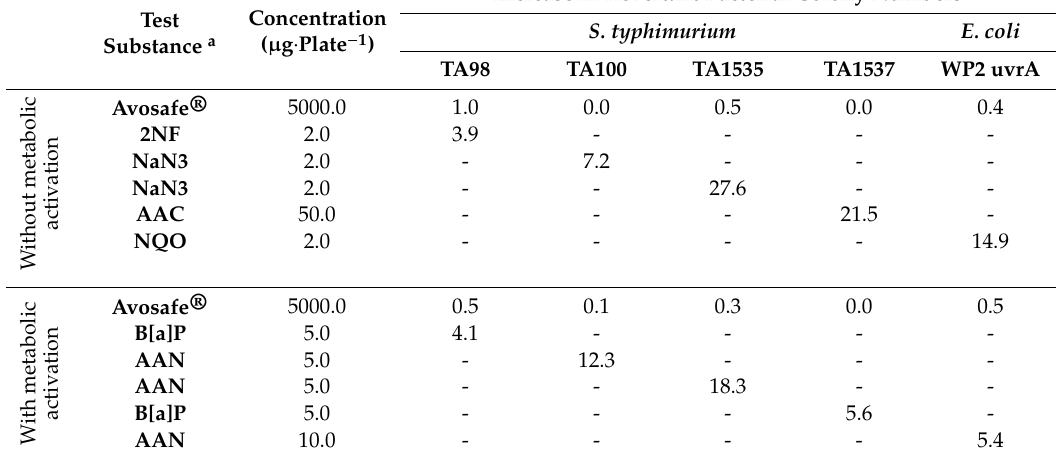
Table 2. Fold increase in revertant colony numbers of tester strains (relative to their vehicle) following the exposure to positive controls and to an avocado seed extract enriched in acetogenins (Avosafe ® ), with and without metabolic activation. Increase in Revertant Bacterial Colony Numbers Concentration Test ( µ g · Plate − 1 ) Substance a